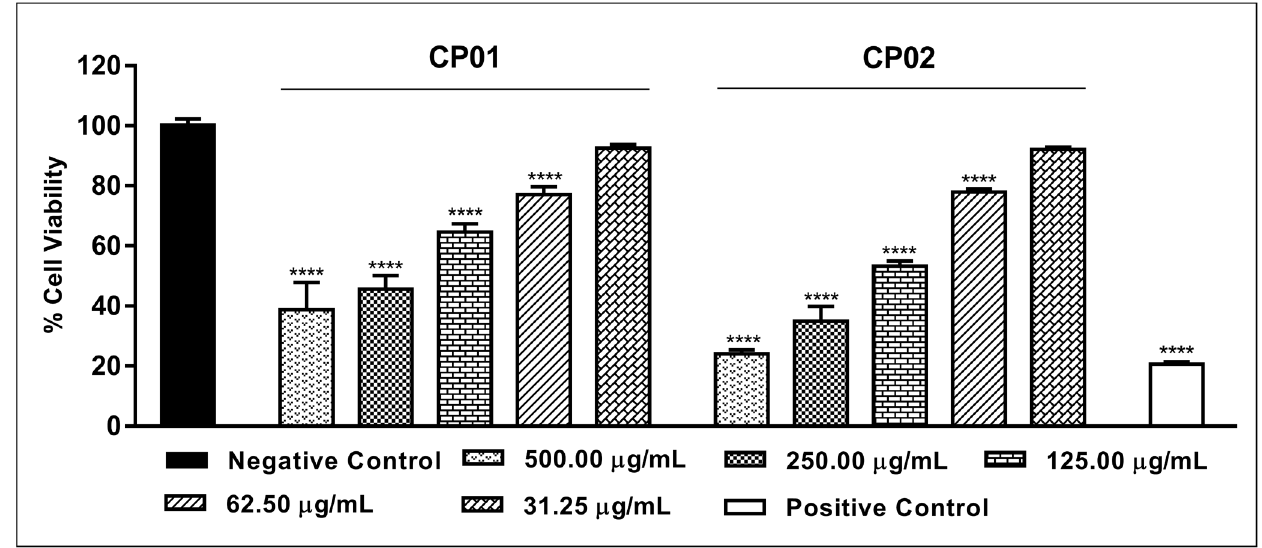
concentration range was 500 to 31.25 µg/mL. Data are presented as means of values ± SD (n = 4). ANOVA followed by Tukey’s test, used as post hoc. Significant values: ****p<0.0001, compared to negative control. CP01: glycerin (GLY - 70 %) and grain alcohol (GA - 30 %); CP02: propylene glycol (PG - 70 %) and grain alcohol (GA - 30